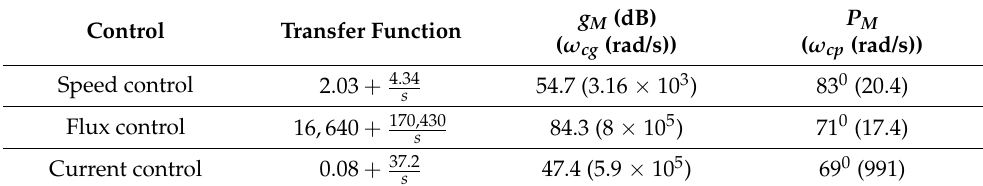
Table 3. IFOC control of